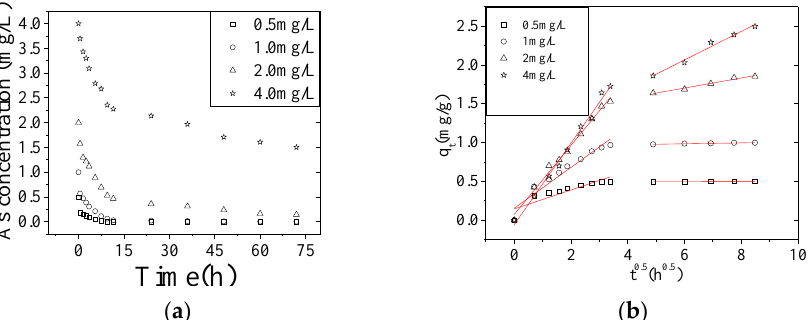
Figure 2. Adsorption kinetics of As(V) on NZVI/AC. ( a ) Effect of the initial concentration of As(V) on its adsorption on NZVI/AC as a function of incubation time. ( b ) Effect of the initial concentration of As(V) on q t and intraparticle diffusion model fit for the As(V) removal at different initial As(V) concentrations by NZVI/AC. Conditions: pH = 6.5, 150 rpm, 20 × 40 mesh particle size, adsorbent dosage = 1.5 g/L, t = 72 h, T = 298 K, C 0 = 0.5, 1.0, 2.0, and 4.0 mg/L.